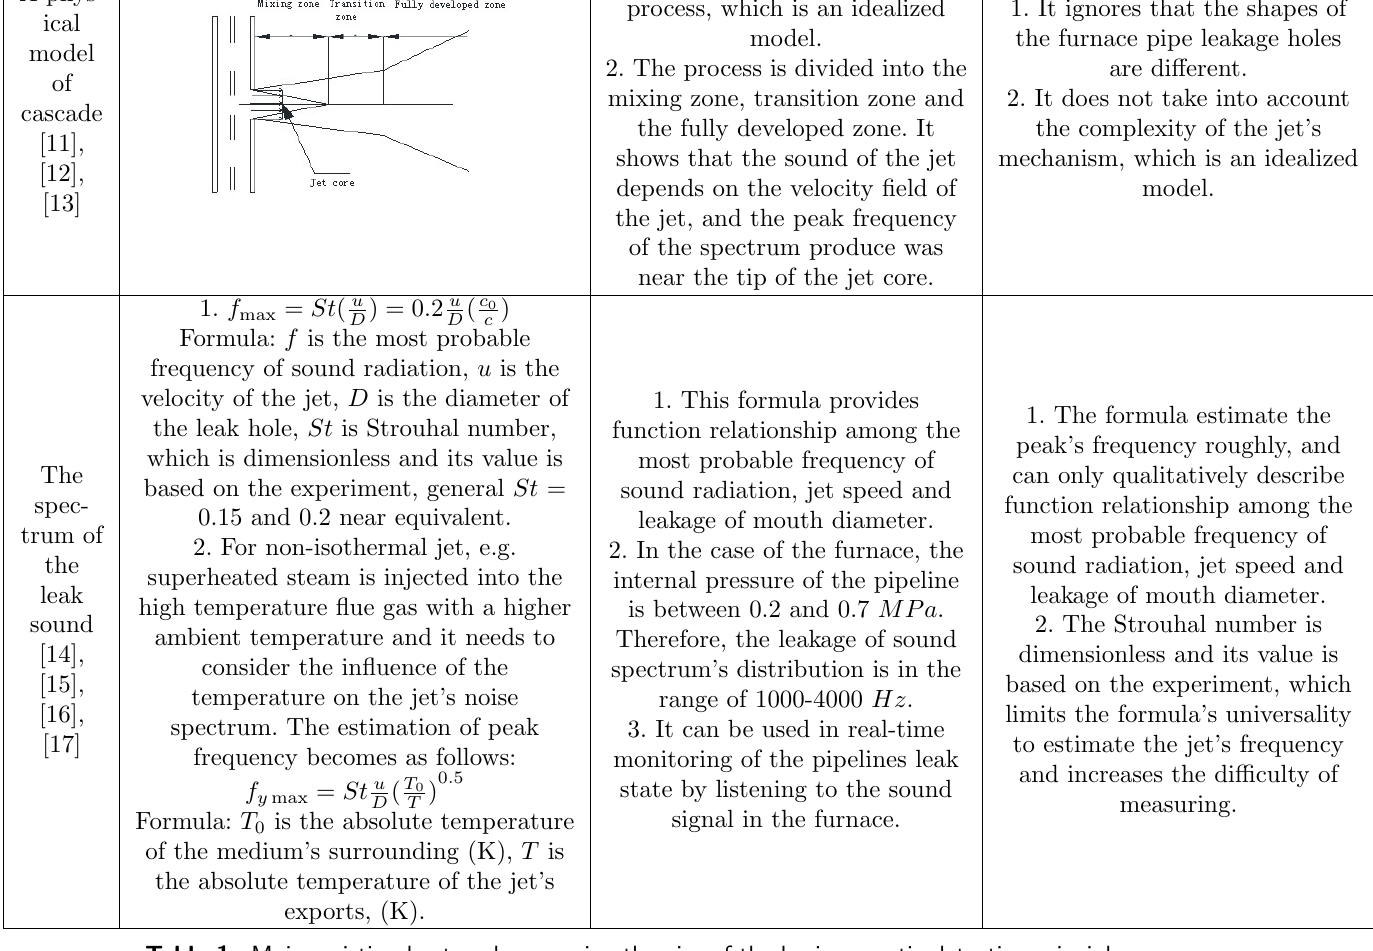
Table 1. Major existing heat exchanger pipe theories of the basic acoustic detection